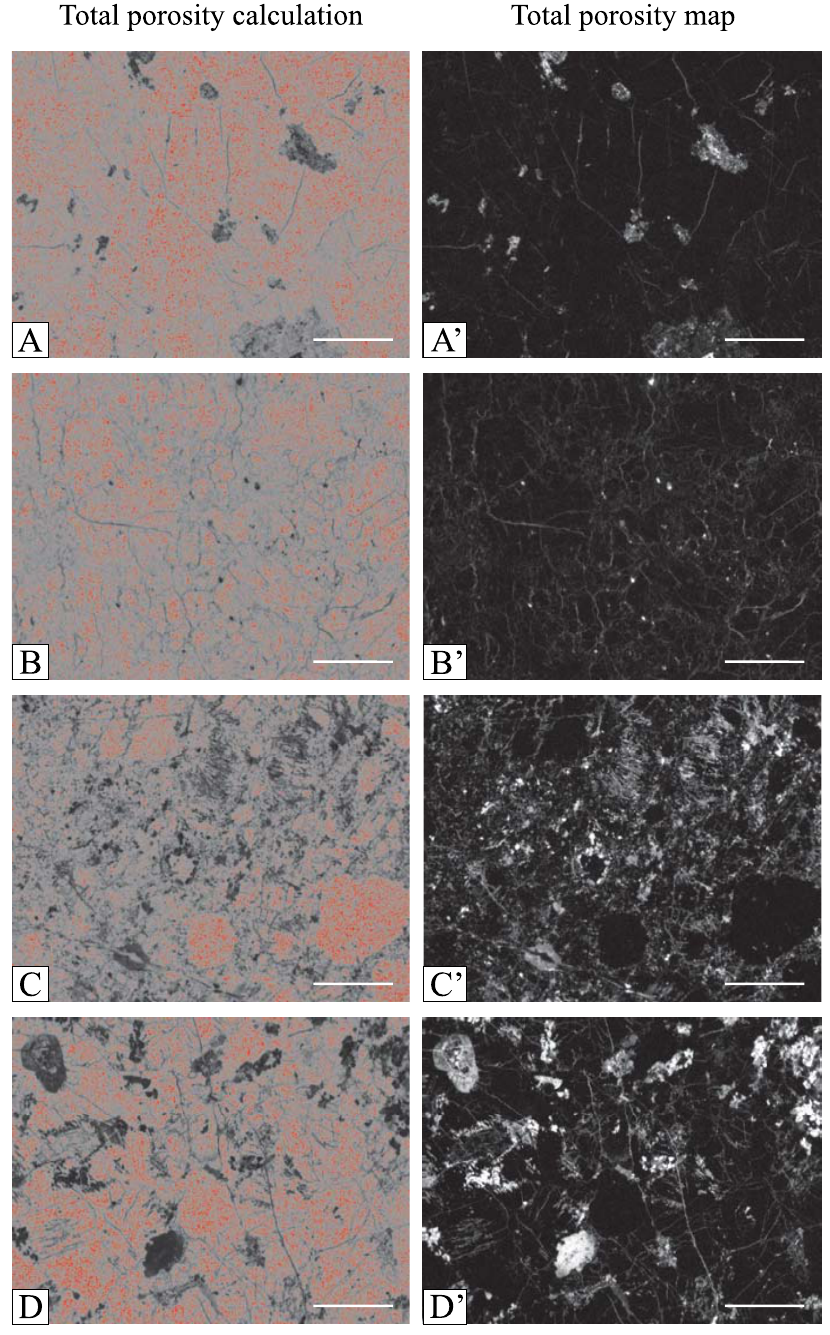
Fig. 5 – In the image generated by the Autoradio software during total porosity calculation (left, A-D), small red points correspond to near null porosity pixels that are not computed. Total porosity maps (right, A’-D’) were obtained after total porosity calculation and conversion of the logarithmic-scale grey level intensities of the autoradiography to linear (0-100%) grey level intensities. The darker zones (higher porosity) of the autoradiography (black = 100% porosity) correspond to inverse tonalities (white = 100% porosity) in the total porosity maps. A to D (left) and A’ to D’ (right) correspond to the same image areas showed in figure 2. Scale bars are 0.5 cm length.